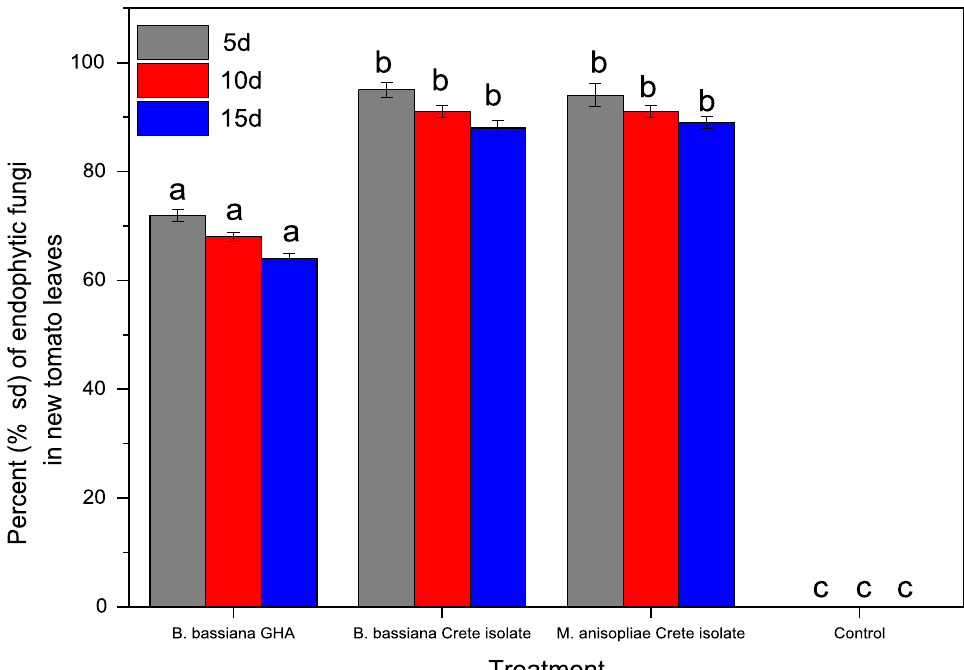
Fig. 1 Mean ( sd; n 24) colonization of tomato leaf parts by Beauveria bassiana Crete isolate and Metarhizium anisopliae Crete isolate and B. ± = bassiana GHA strain at 5 days, 10 days and 15 days after exposure. Mean way (Bonferroni’s test: P <